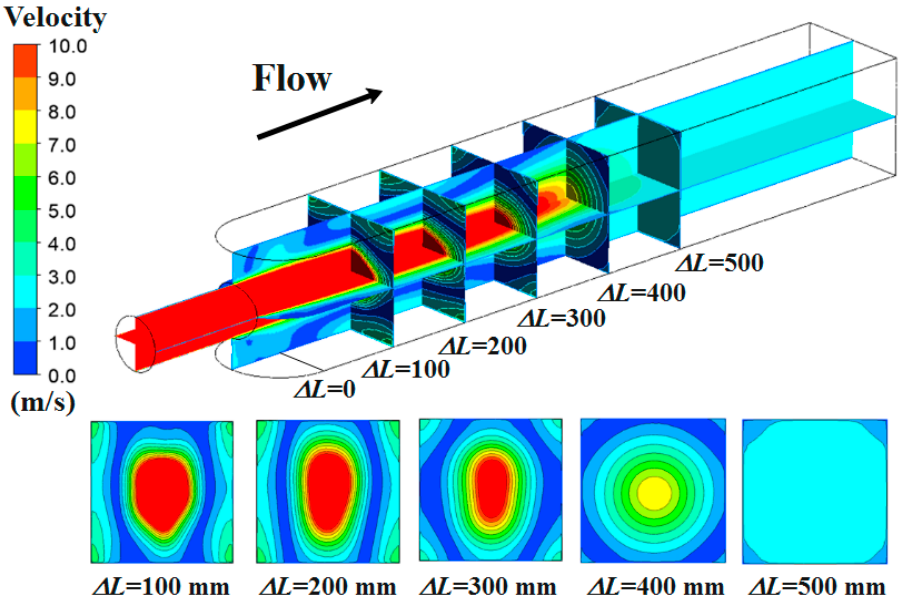
Figure 6. Flow distribution in the entrance head without SPB and its five cross-sections.